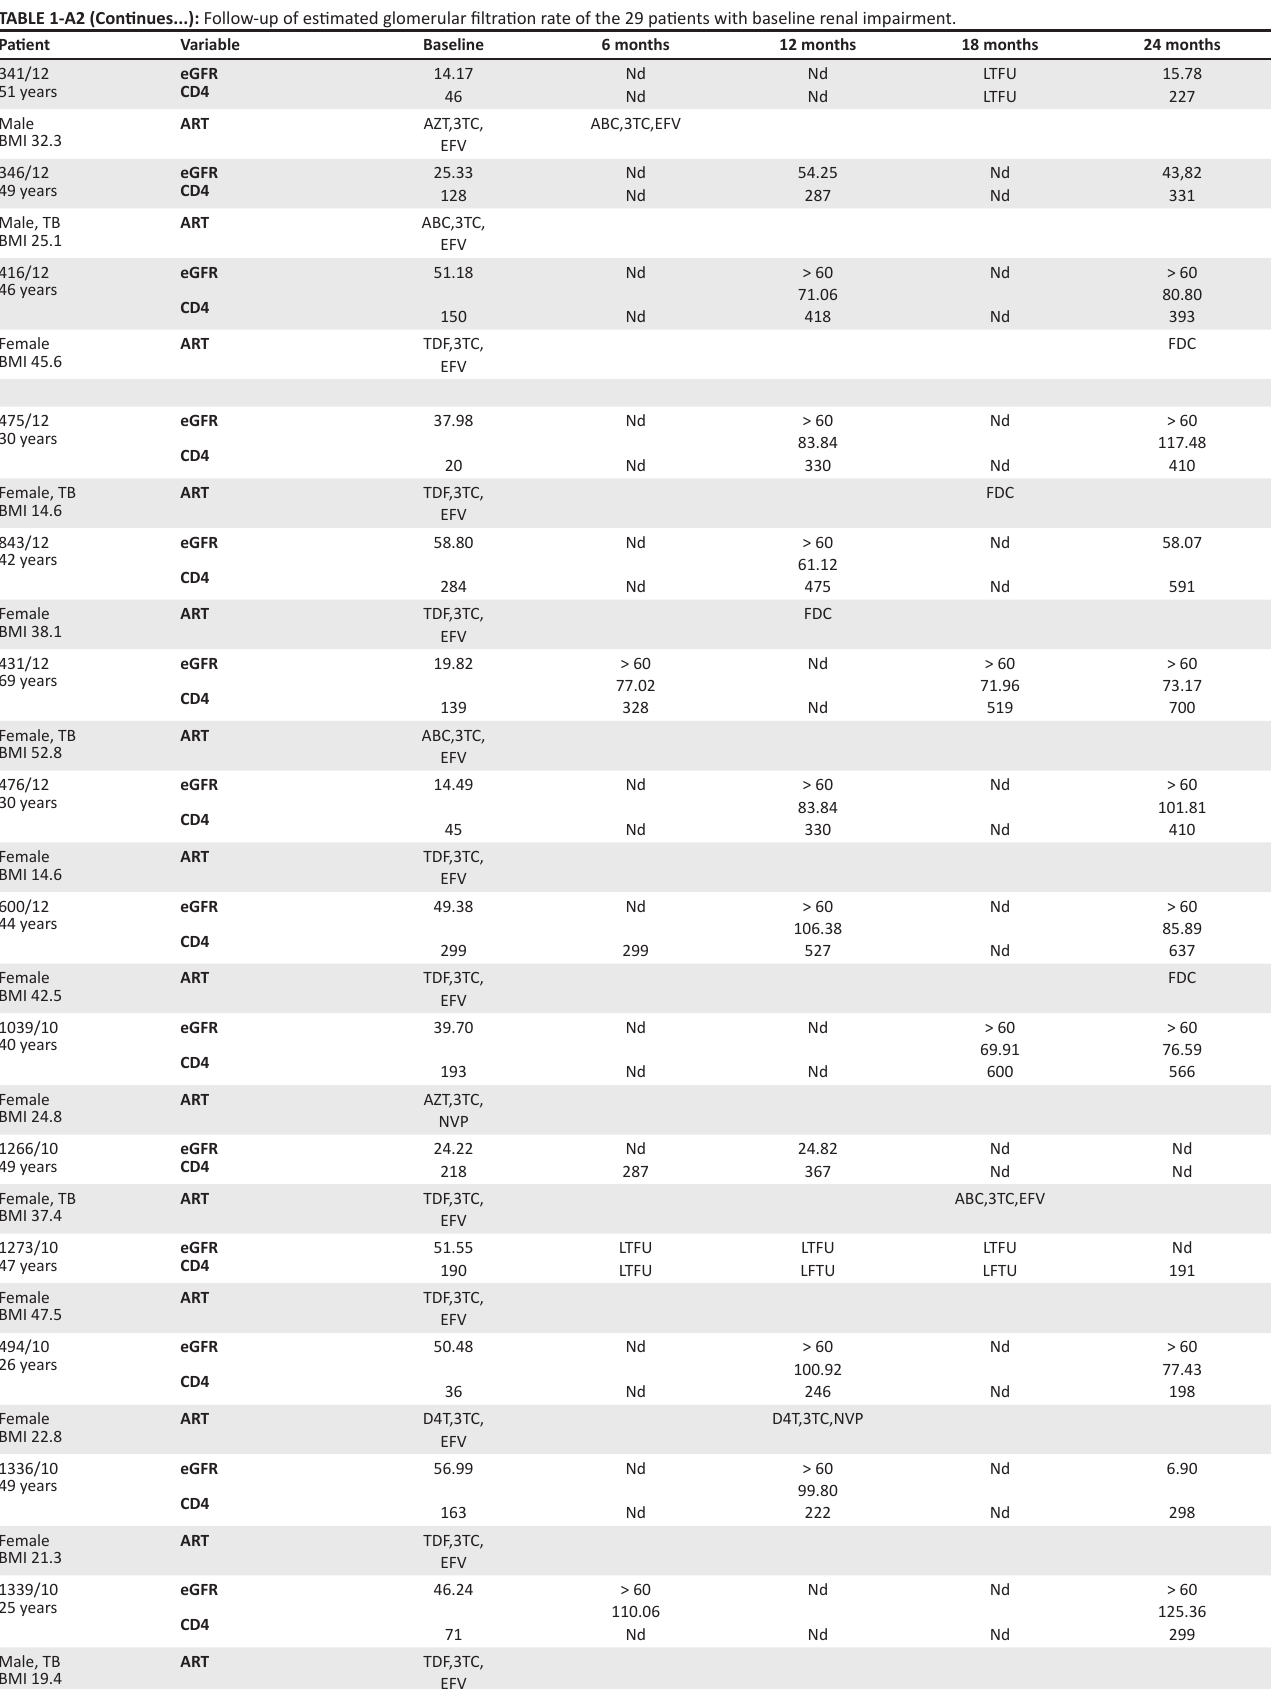
TABLE 1-A2 (Continues...): Follow-up of estimated glomerular filtration rate of the 29 patients with baseline renal impairment.